Question: From the figure, is the trend upward or downward?
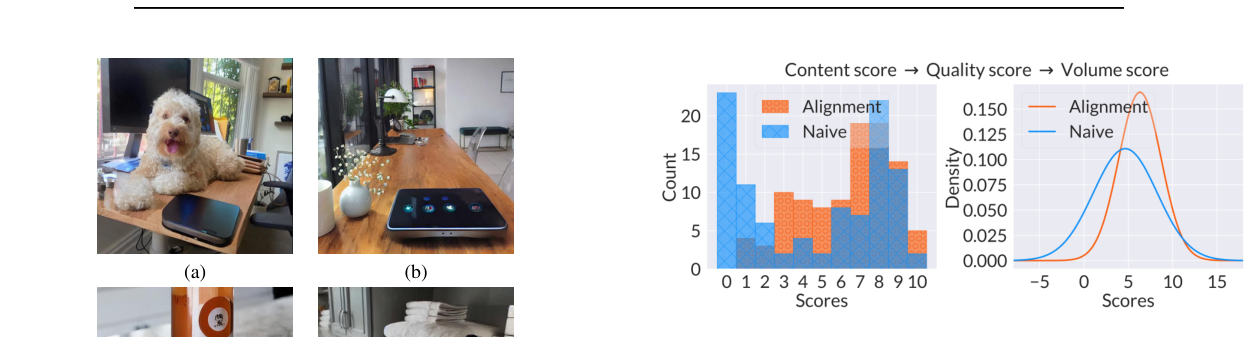
Answer: increasing